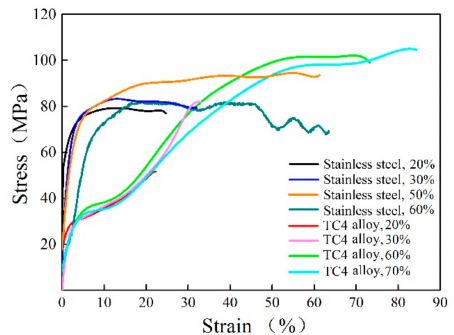
Figure 3. Stress-strain curve of the sandwich structure with the stainless steel andTC4 alloy package during the hot-compression